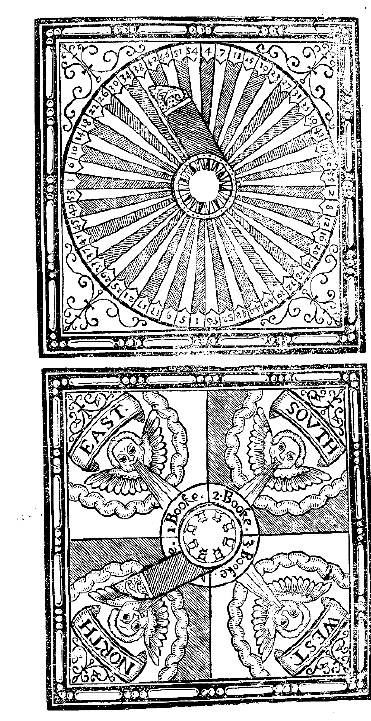
Figure : Wither’s lottery dials. A Collection of Emblemes, Ancient and Moderne … Printed by A[ugustine] M[athewes] for Robert Milbourne, and are to be sold at the Grayhound in Pauls Church-yard, MDCXXXV), last folio (v)